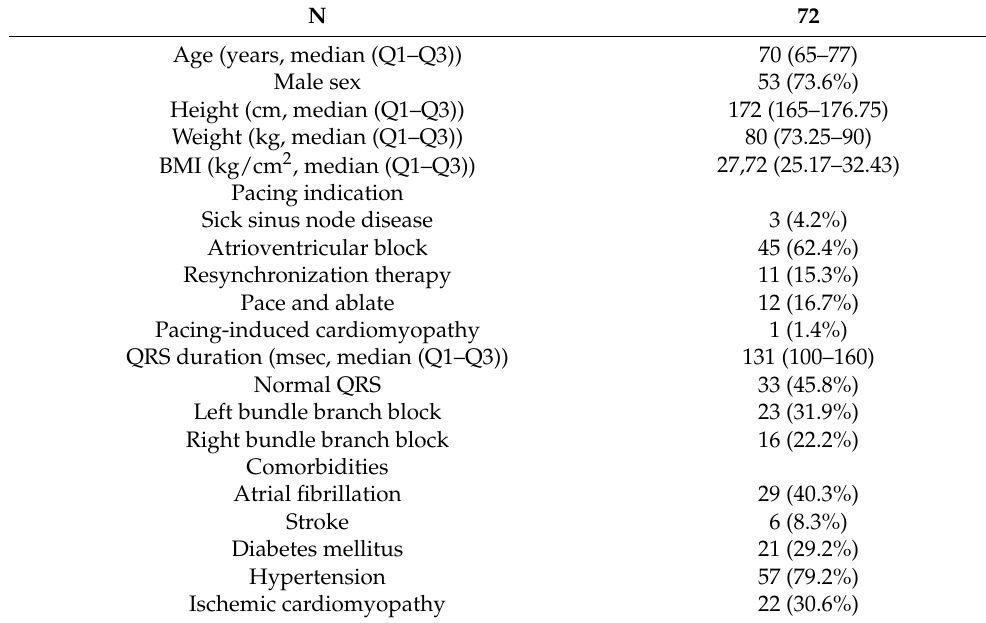
Table 1. Baseline patient